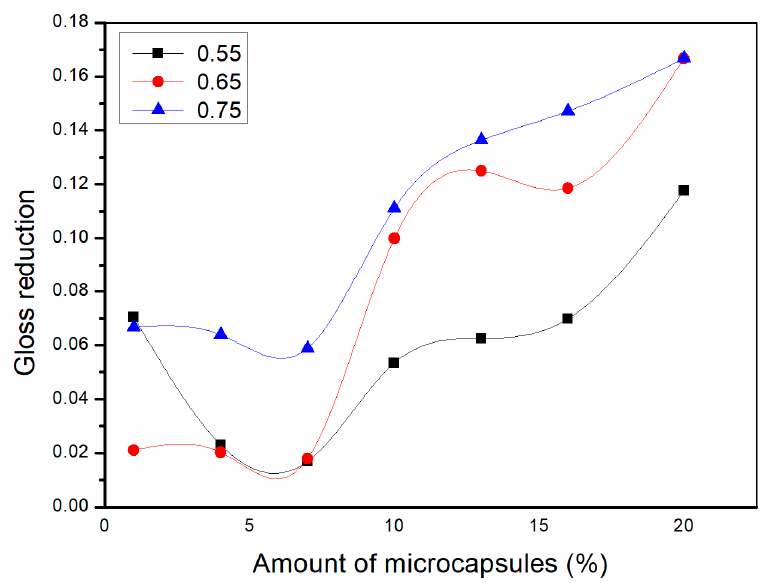
Figure 10. Gloss reduction in the coating after drying at 140 °C for 2 h.